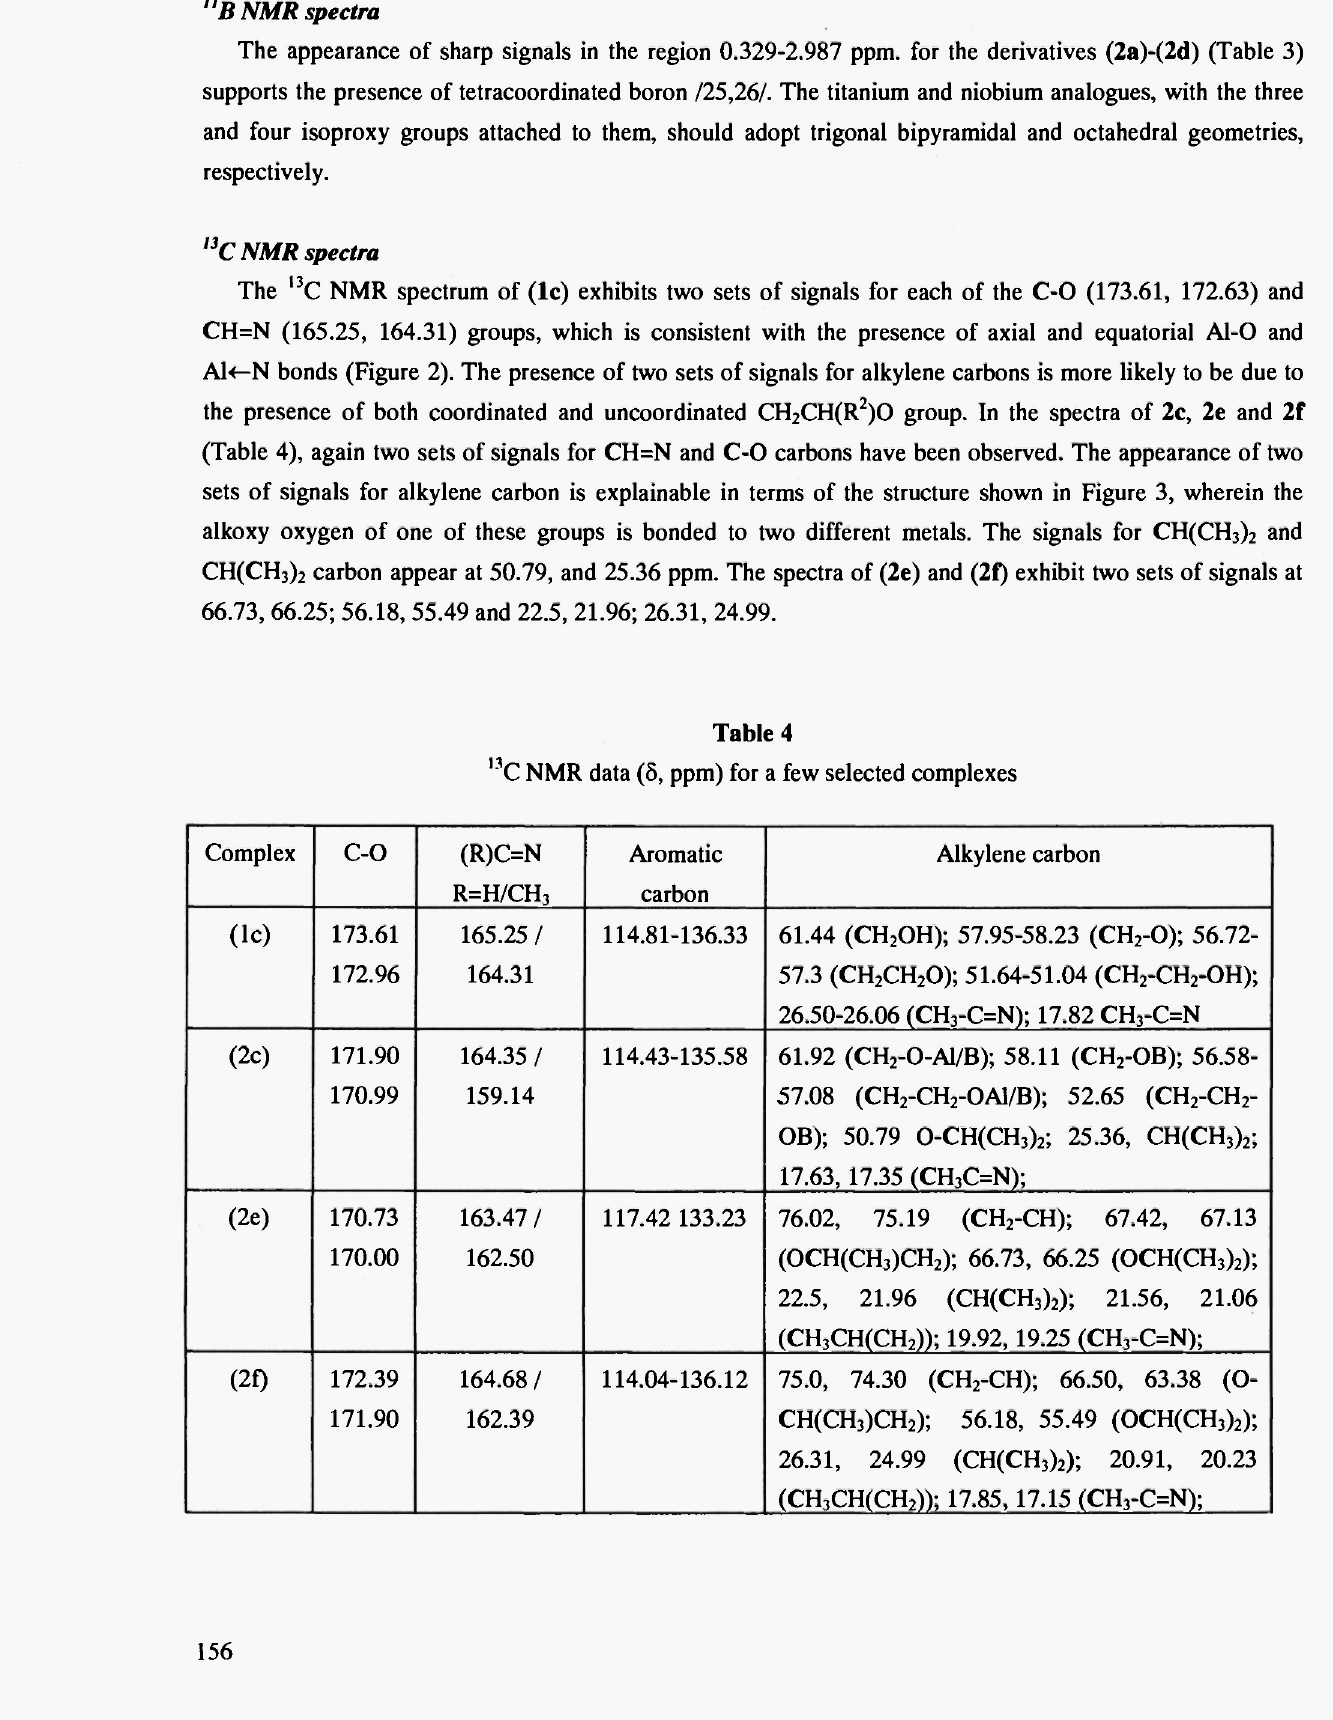
13 C NMR data (δ, ppm) for a few selected